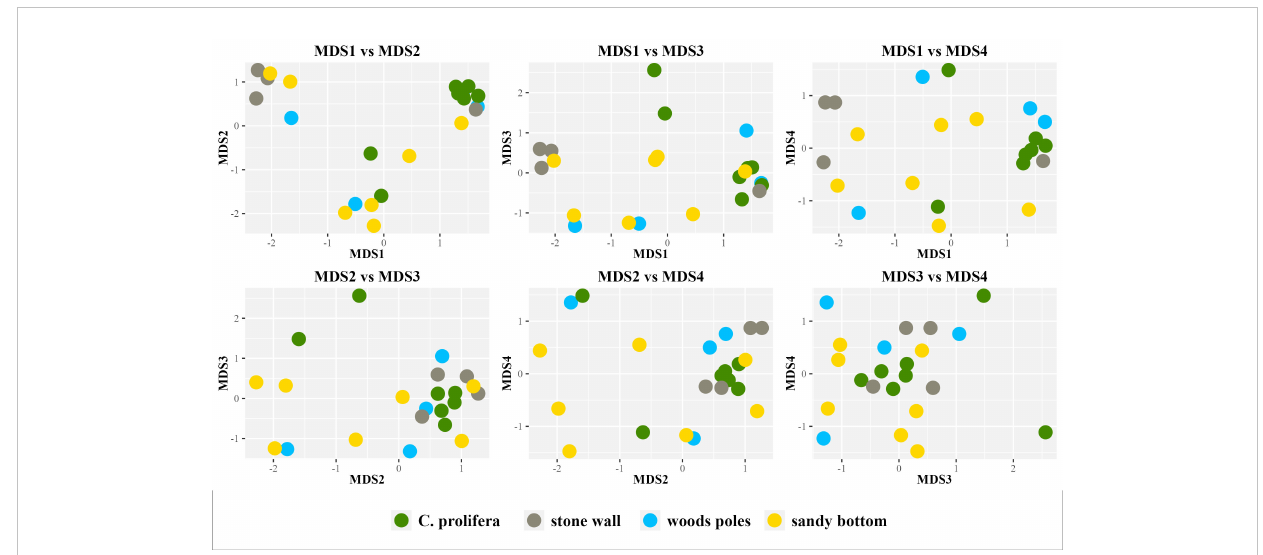
FIGURE 3 nMDS plot based on the Bray-Curtis dissimilarity matrix. Stress=0.09. nMDS was inferred using four dimensions and up to 100 iterations. All possible combinations of inferred MDS are shown.